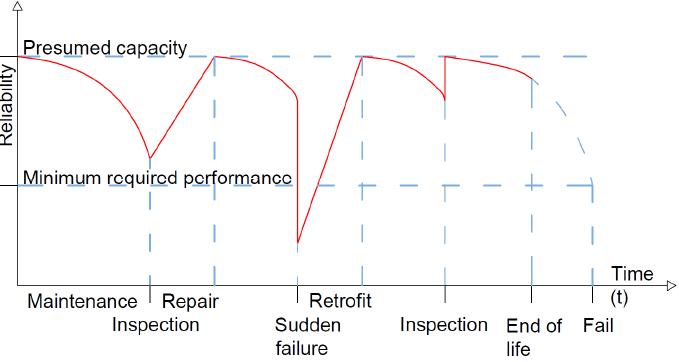
Figure 14. Reliability of construction over time .